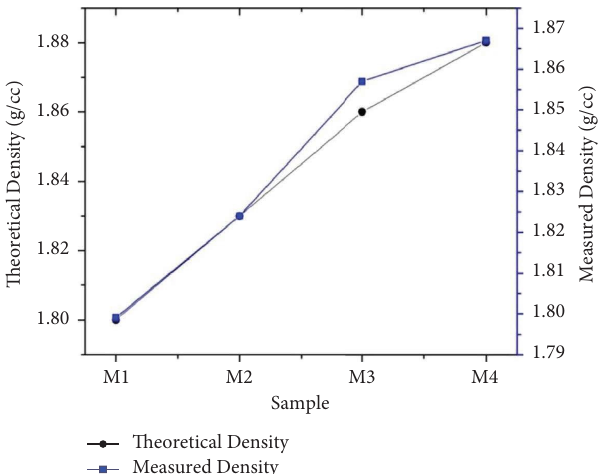
Figure 7: Variation of microhardness of